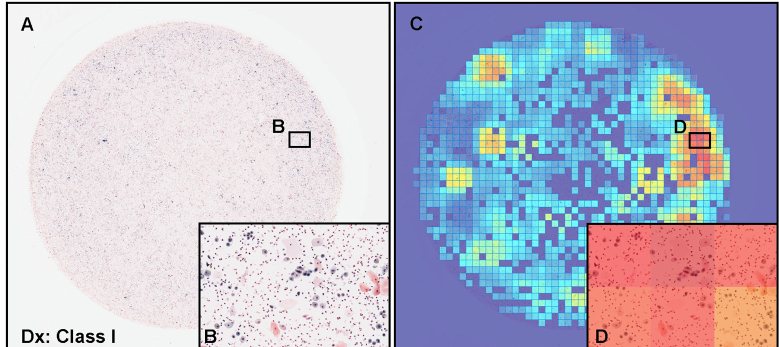
Figure 7. Representative example of false positive prediction. A representative example of neoplastic false positive prediction outputs on urine liquid-based cytology (LBC) whole-slide images (WSIs) from test sets using the ENB1-UC-FS+WS model . According to the cytopathological diagnostic (Dx) report, ( A ) was diagnosed as Class I and consisted of metaplastic squamous epithelial cells and non-atypical (non-neoplastic) urothelial epithelial cells with inflammatory cells ( B ). The heatmap images ( C , D ) show false positive predictions ( D ) which correspond, respectively, to ( B ). The heatmap uses the jet color map where blue indicates low probability and red indicates high